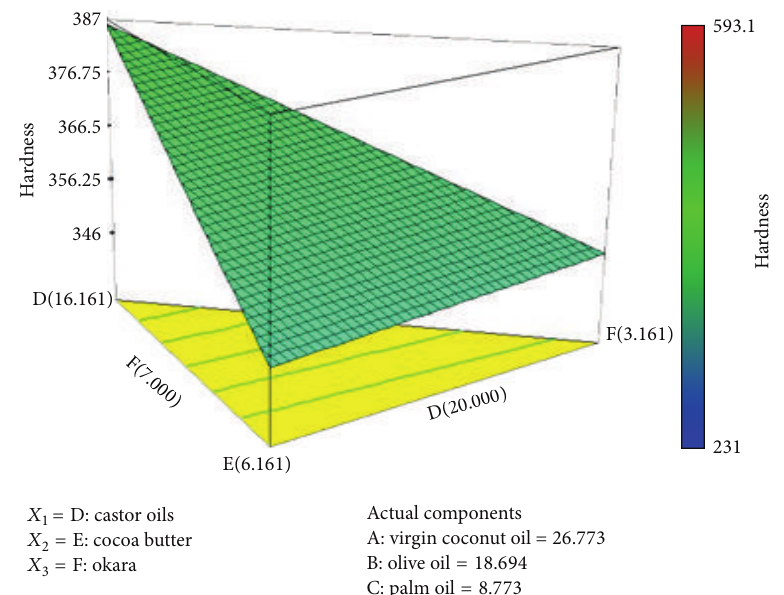
Figure 5: Three-dimensional contour plot illustrating the interaction of palm oil, cocoa butter, and okara towards the response ( 𝑌 ), hardness (N).